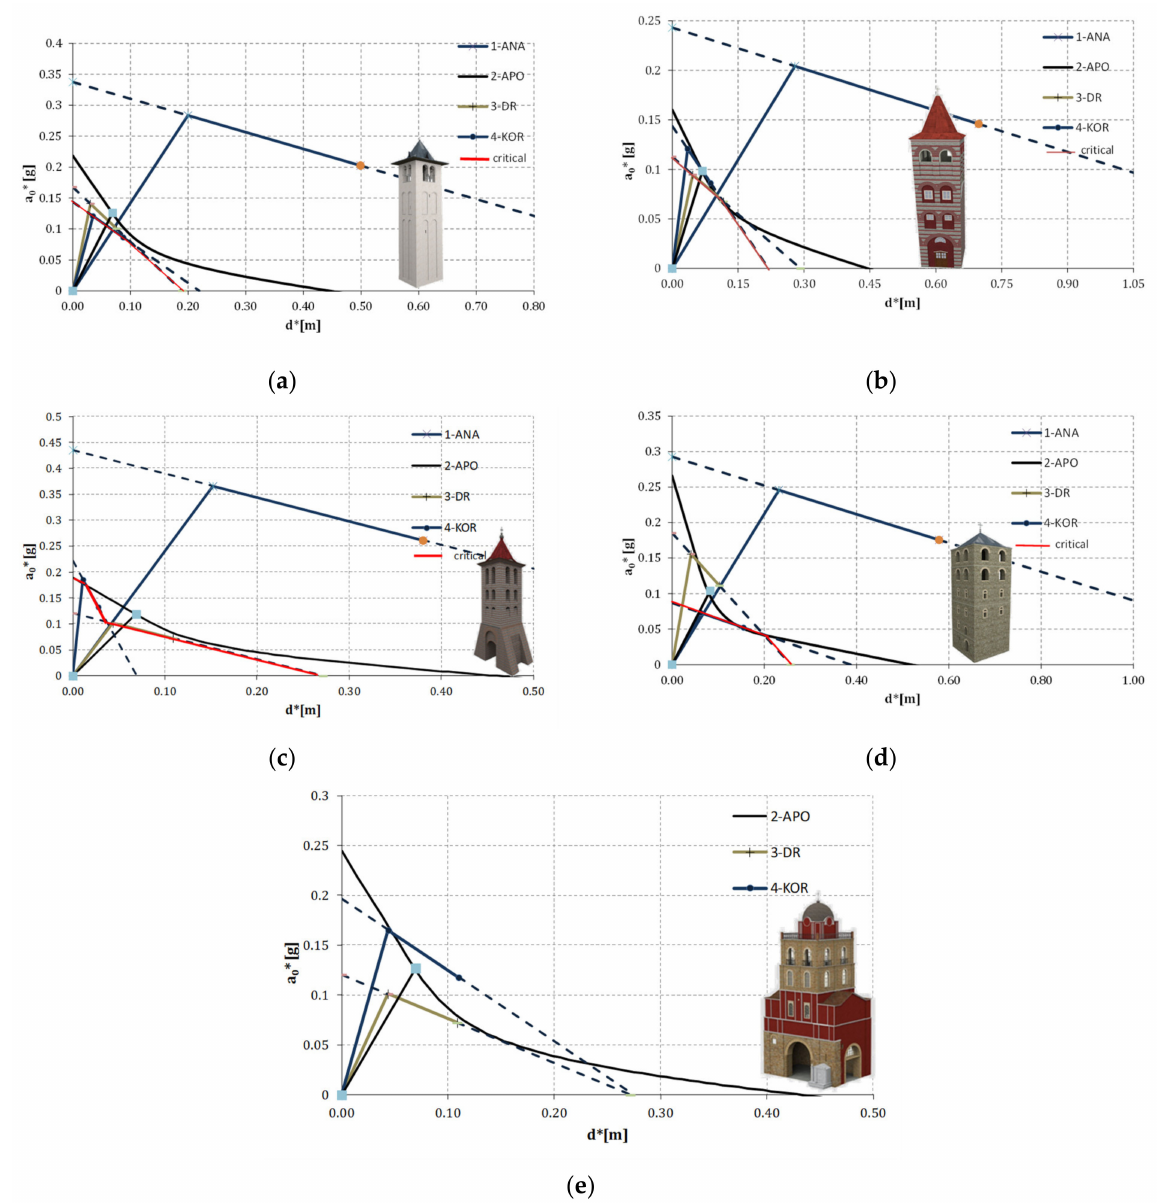
Figure 11. Capacity curves: ( a ) Vatopedi tower, ( b ) Philotheou bell tower, ( c ) Protaton tower, ( d ) Xenophontos bell tower, and ( e ) Iveron bell